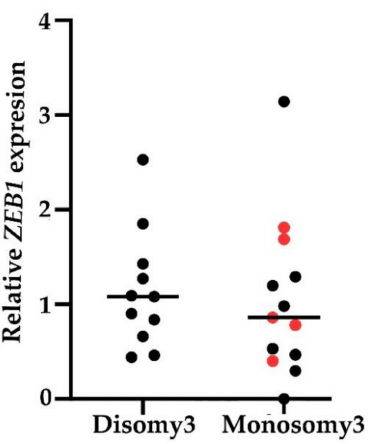
Figure 3. Relative ZEB1 expression in a CD45-depleted peripheral blood fraction of M3 and five metastatic UM patients (highlighted by red) compared to D3. The di ff erence between D3 and M3 ZEB1 expression was not significant.